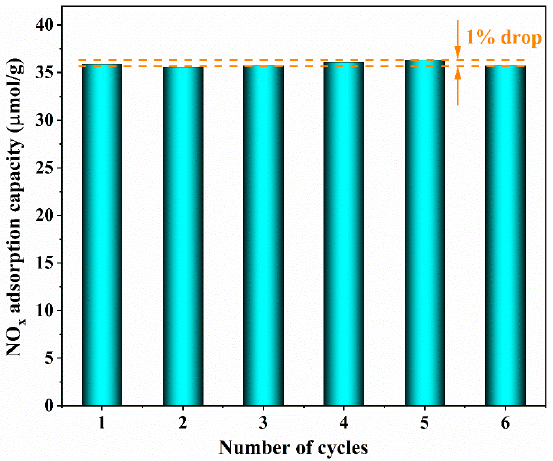
Figure 10. Regeneration cycles of NO x on HZSM-5(35) at 90% RH.